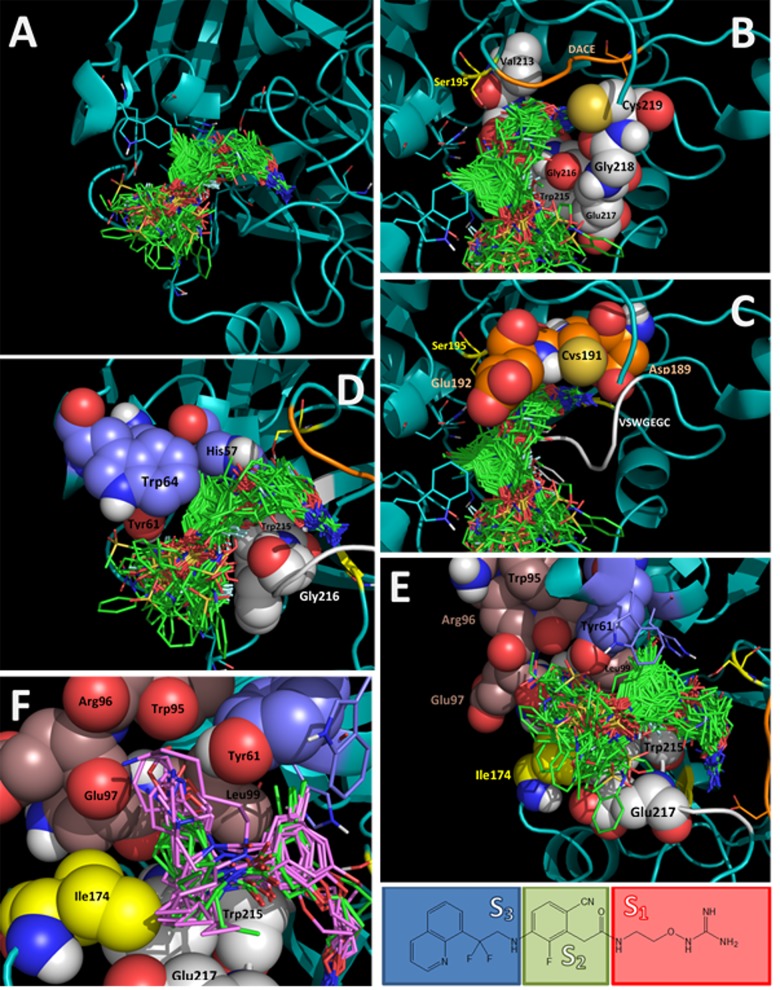
Alignment of all docked structures within the thrombin binding site (docked ligands are in green stick representation in A-E).
(A) Full view of the binding site. (B) Subsite S1, residues of the VSWGEGC motif are represented with white spheres, DACE motif is represented as an orange loop, Ser195 is represented with yellow sticks. (C) Subsite S1, residues of the DACE motif are represented with orange spheres, VSWGEGC motif is represented as a white loop, Ser195 is represented with yellow sticks. (D) Subsite S2, residues His57, Tyr61, and Trp64 are represented with violet spheres, and residues Trp215 and Gly216 from the VSWGEGC motif are represented with white spheres. (E, F) Subsite S3, residues of the WRENL motif are represented with brown spheres, residues Trp215 and Glu217 from the VSWGEGC motif are represented with white spheres, and Ile174 is represented with yellow spheres. In f several compounds that have a P1 moiety with two branches are represented: compounds with two hydrophobic branches are represented with green sticks, and compounds with one of the branches containing a polar group are represented with pink sticks.